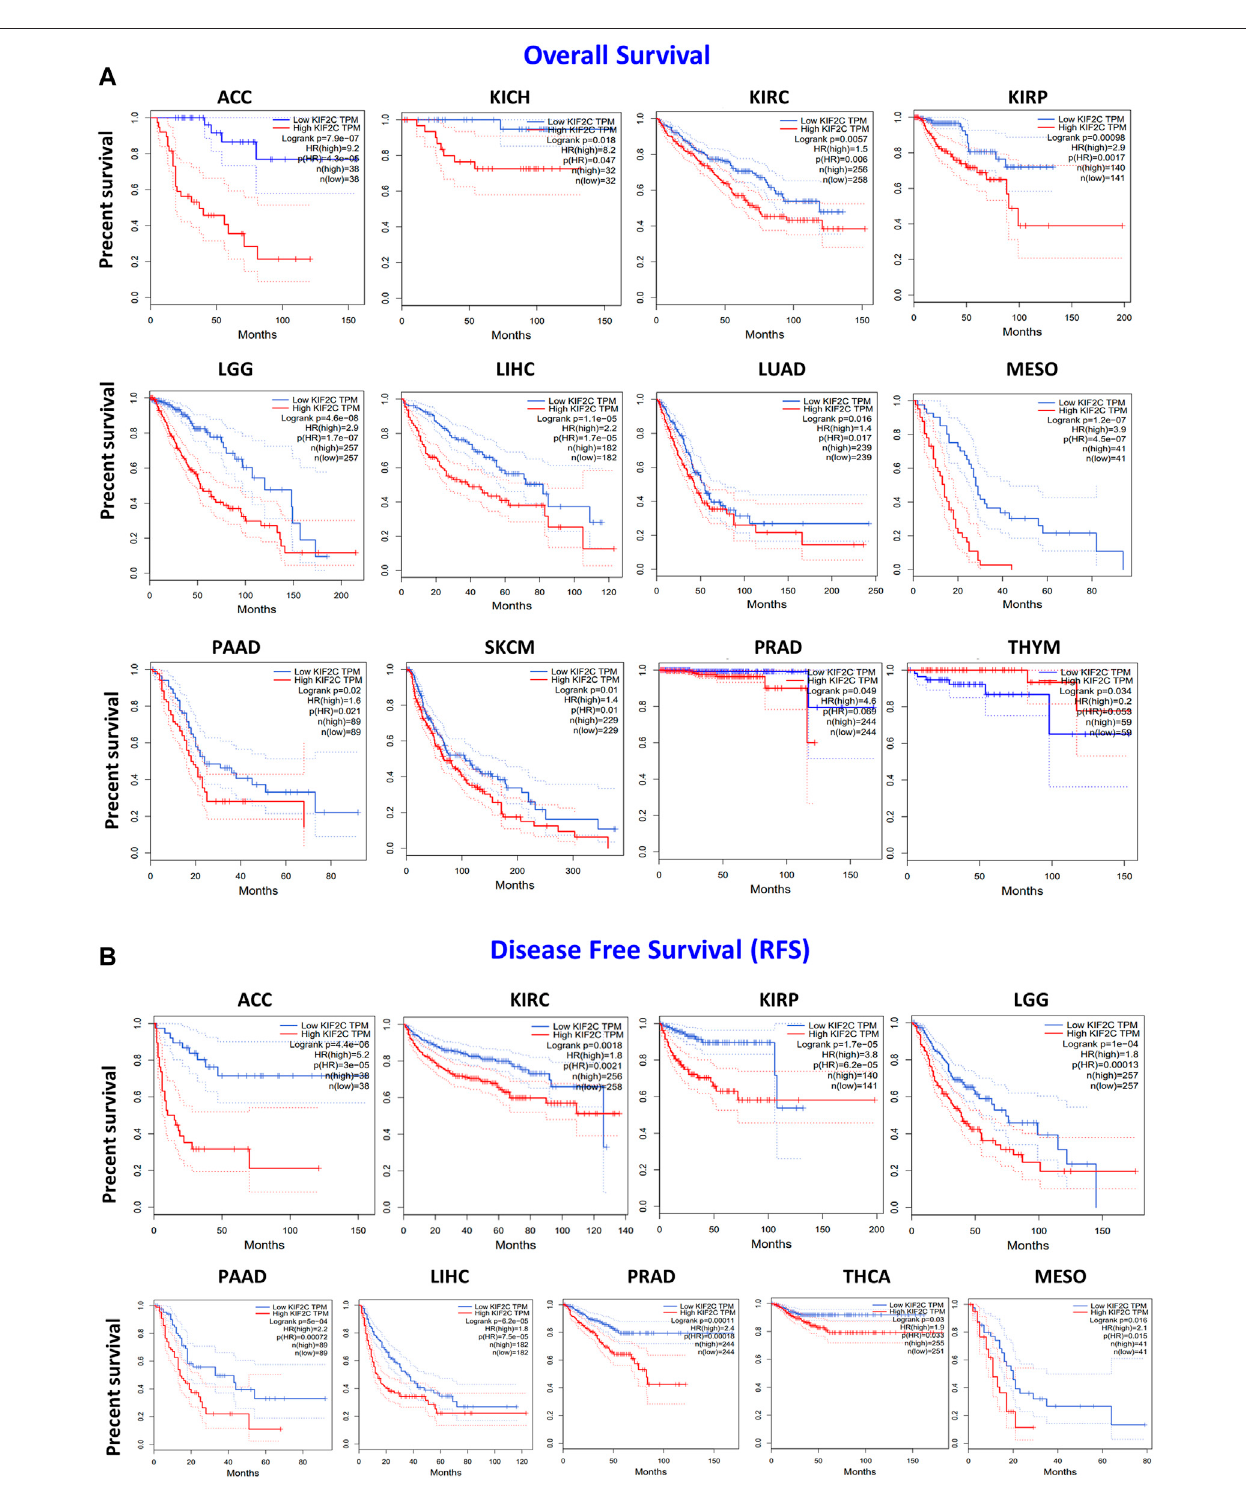
FIGURE 3 | KIF2C expression and its association with survival in cancers based on TCGA data analysis. GEPIA2 software was used to analyze (A) overall survival rate and (B) disease-free survival rate of different tumors in TCGA. Survival plots and Kaplan – Meier curves showing positive results.